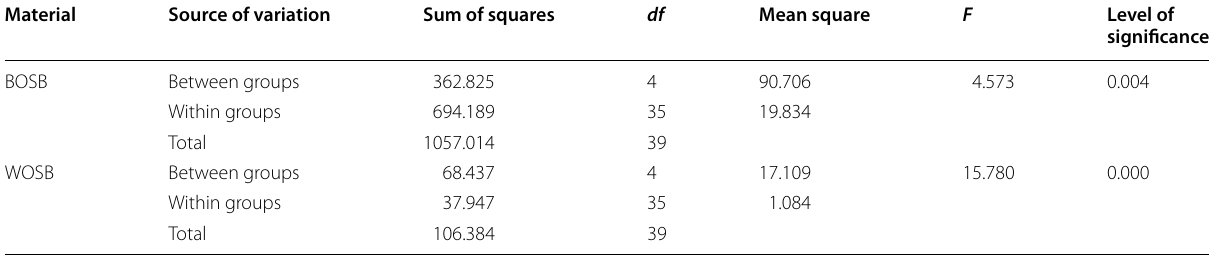
Table 3 ANOVA results of compression moment of joints